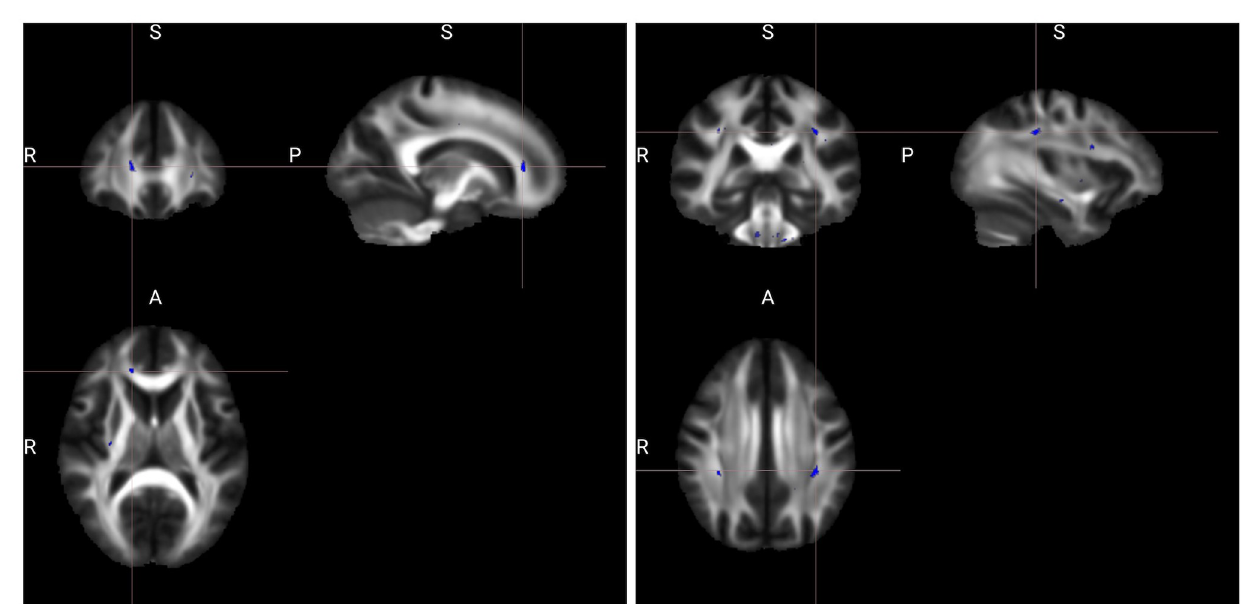
Fig 2. Significant regions in which the FA showing significant effect, among GAD 1 a | YCU (left) and GAD 1 b | YCU (right). The background is the average FA map. The viewer’s left side of the axial slice is the left hemisphere of the displayed brain. The clusters shown are the “thickened” version of the skeletonized results, using the FSL tbss_fill